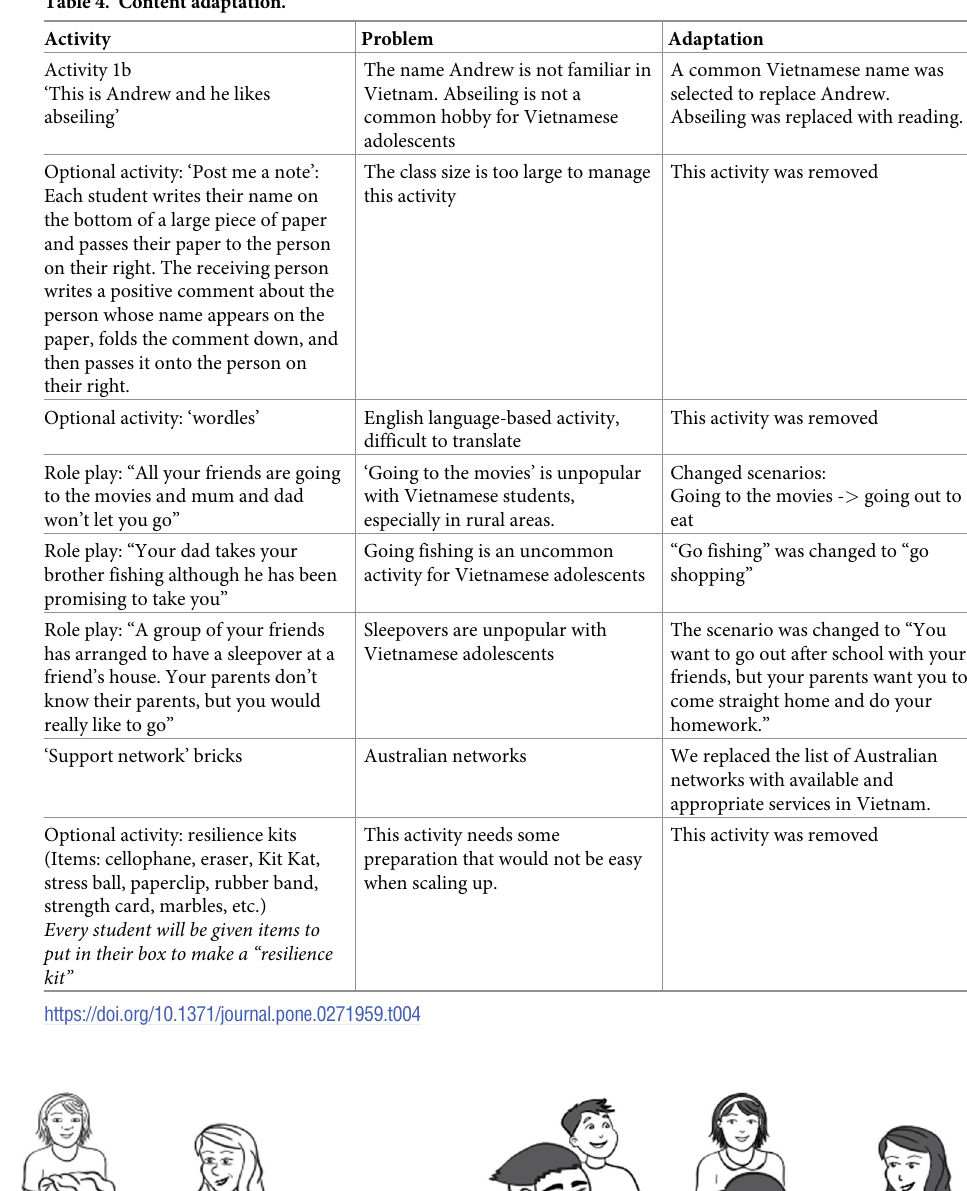
Table 4. Content adaptation.